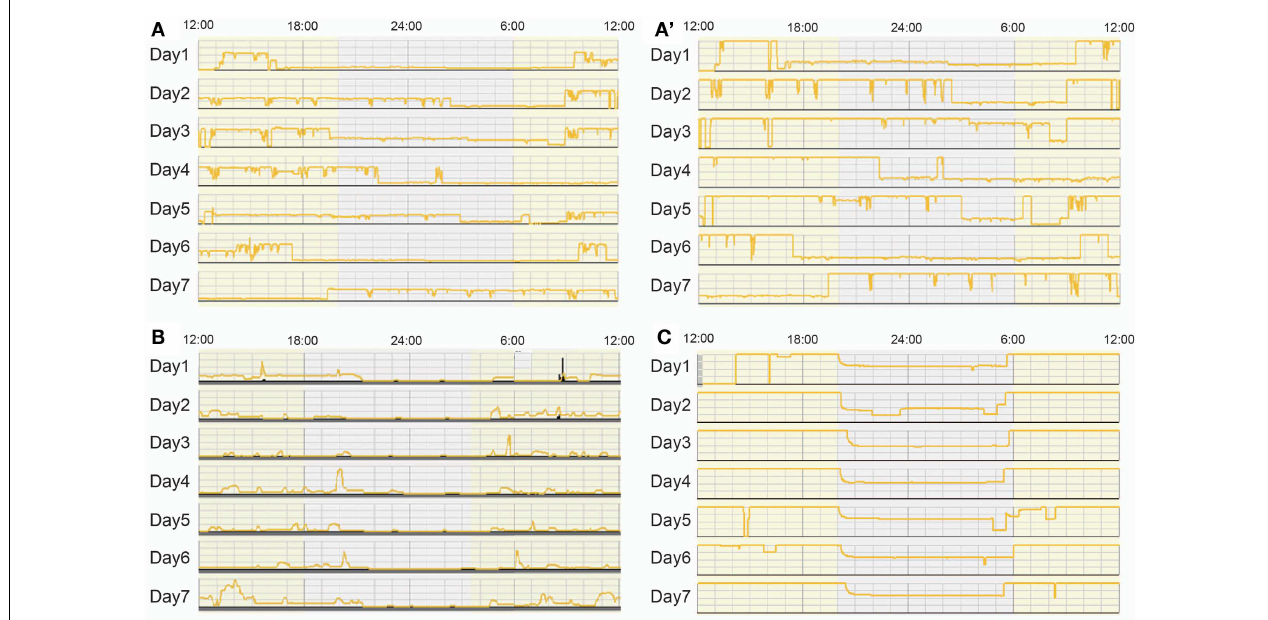
the time throughout the 1-week observation. (B) Bed-site illumination in another NICU at a maximum illumination of 100lux.The illumination was less than 25lux most of the time throughout the 1-week observation (a continuous dark condition). (C) Bed-site illumination in another NICU at a maximum illumination of 100lux.The illumination was more than 50lux most of the time throughout the 1-week observation (a constant light